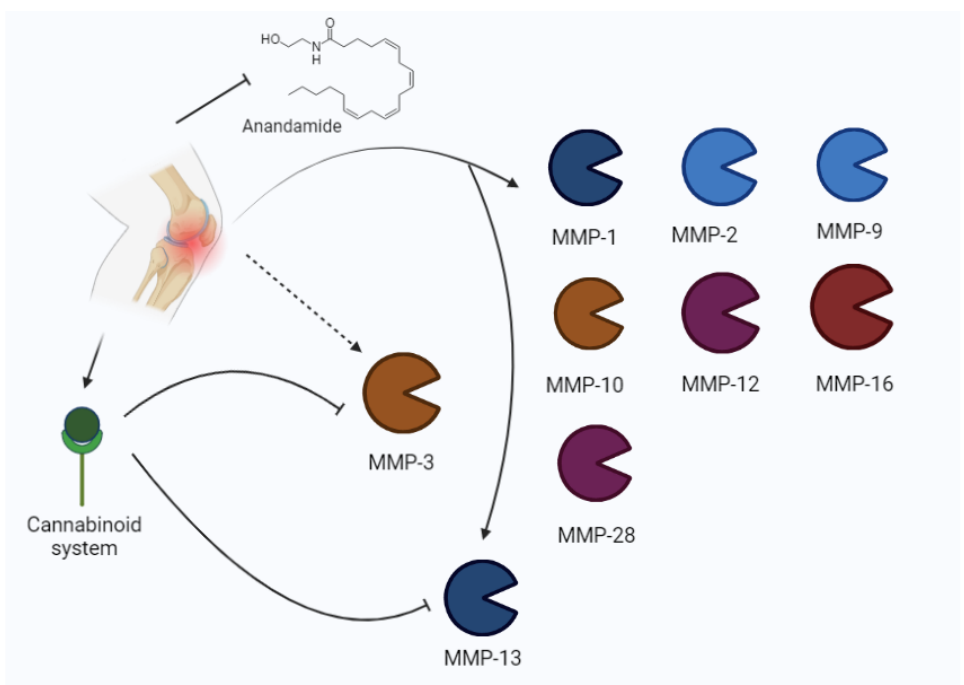
Figure 4. Osteoarthritis may induce an increase in MMPs (MMP-1, MMP-2, MMP-9, MMP-10, MMP- 12, MMP-16, 28, MMP-3, MMP-13) and the modulation of the cannabinoid system. The cannabinoid system inhibits MMP-3 and MMP-13.